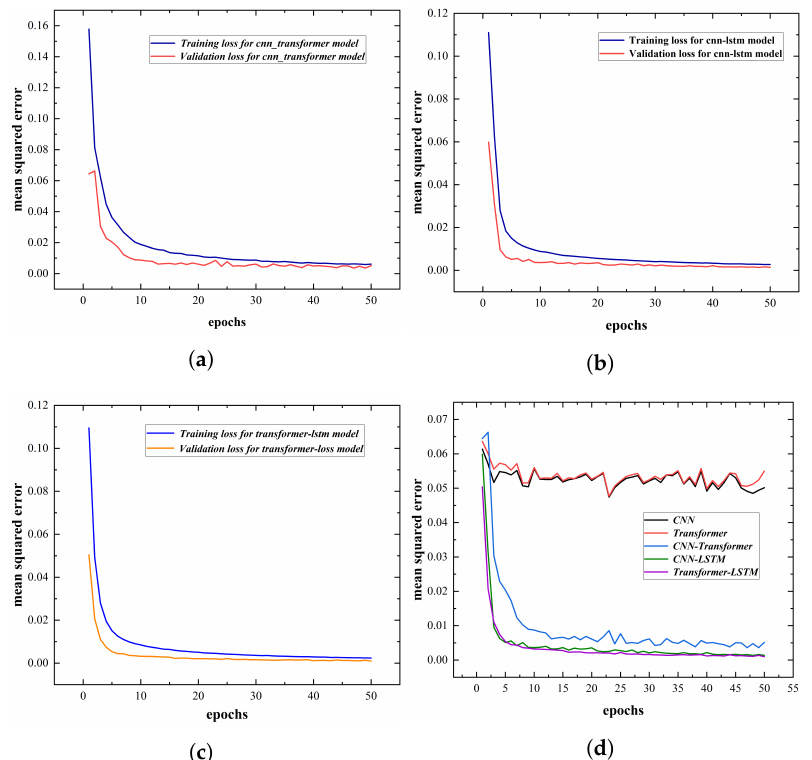
Figure 6. Loss vs Epoch Curve : ( a ) Training and validation loss curve of CNN-Transformer model ( b ) Training and validation loss curve of CNN-LSTM model ( c ) Training and validation loss curve of XTM model ( d ) Comparison of validation loss over epoch of different